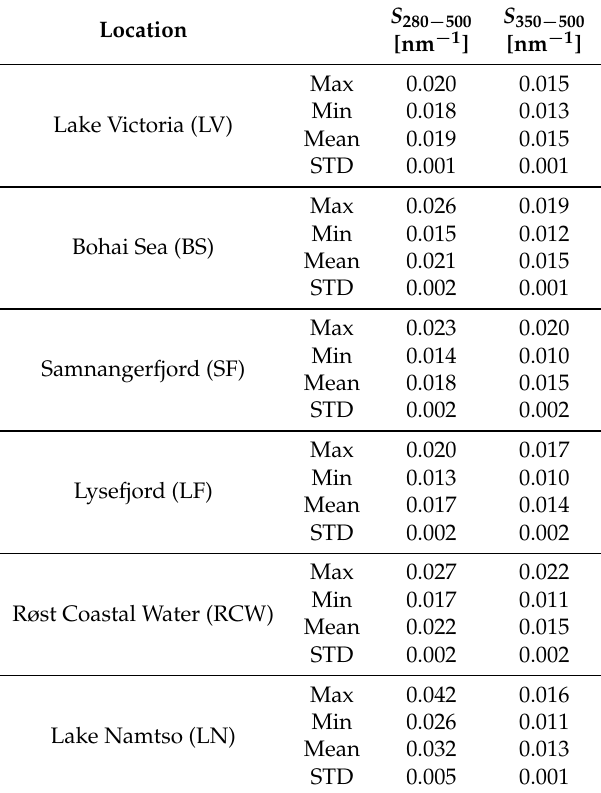
Table 3. The maximum (max), minimum (min), mean, and standard deviation (STD) values for CDOM absorption spectral slopes S 280 − 500 and S 350 − 500 at each study